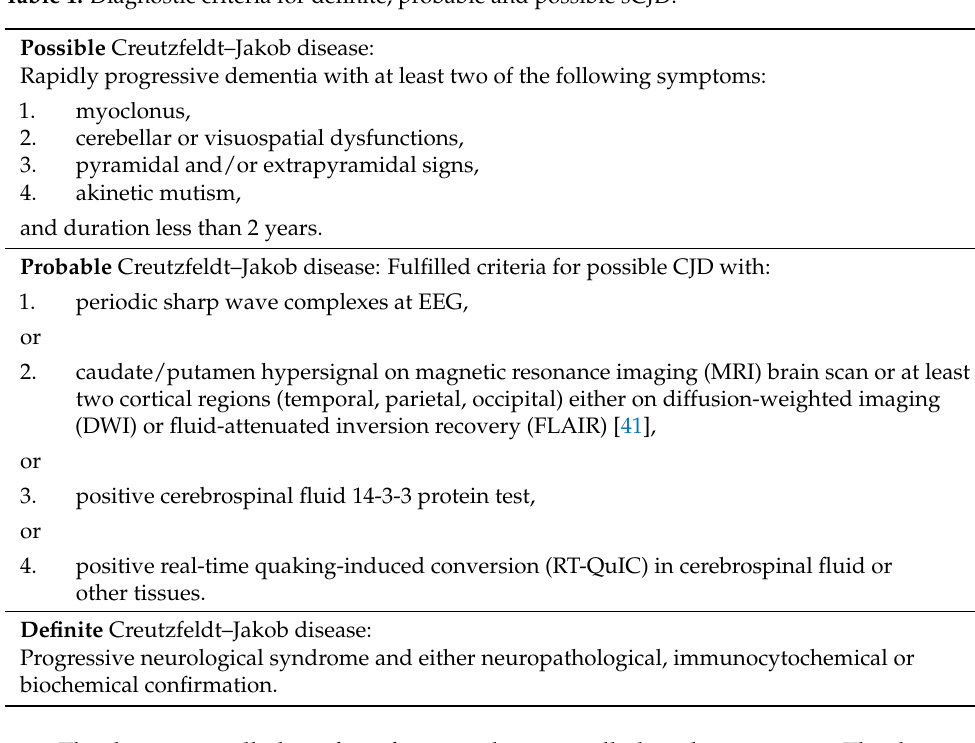
Table 1. Diagnostic criteria for definite, probable and possible